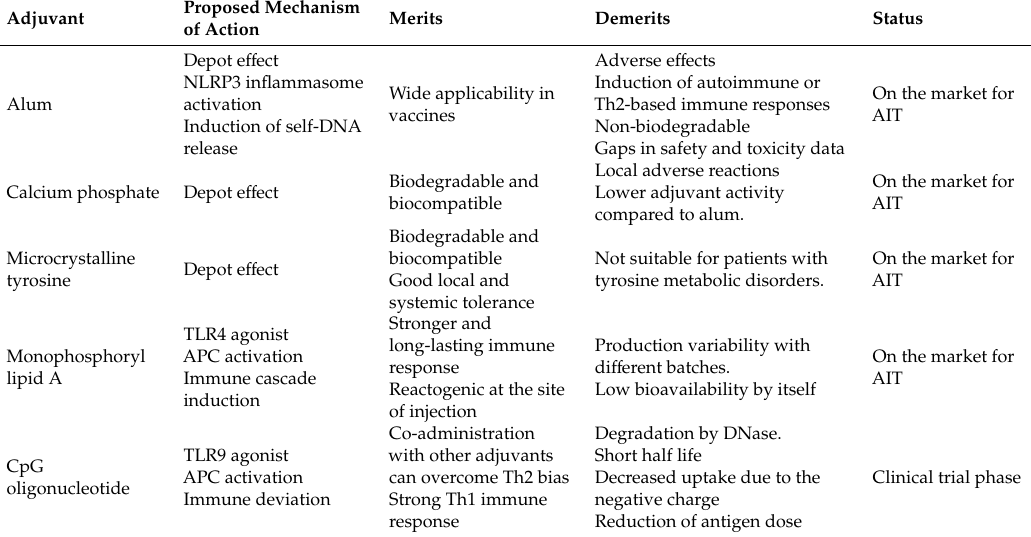
Table 1. Adjuvants for AIT with their proposed mechanism of action, merits, demerits, and status in the